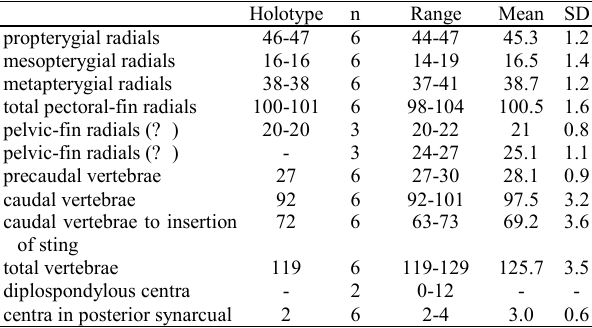
Table 2. Counts on specimens of Potamotrygon boesemani .